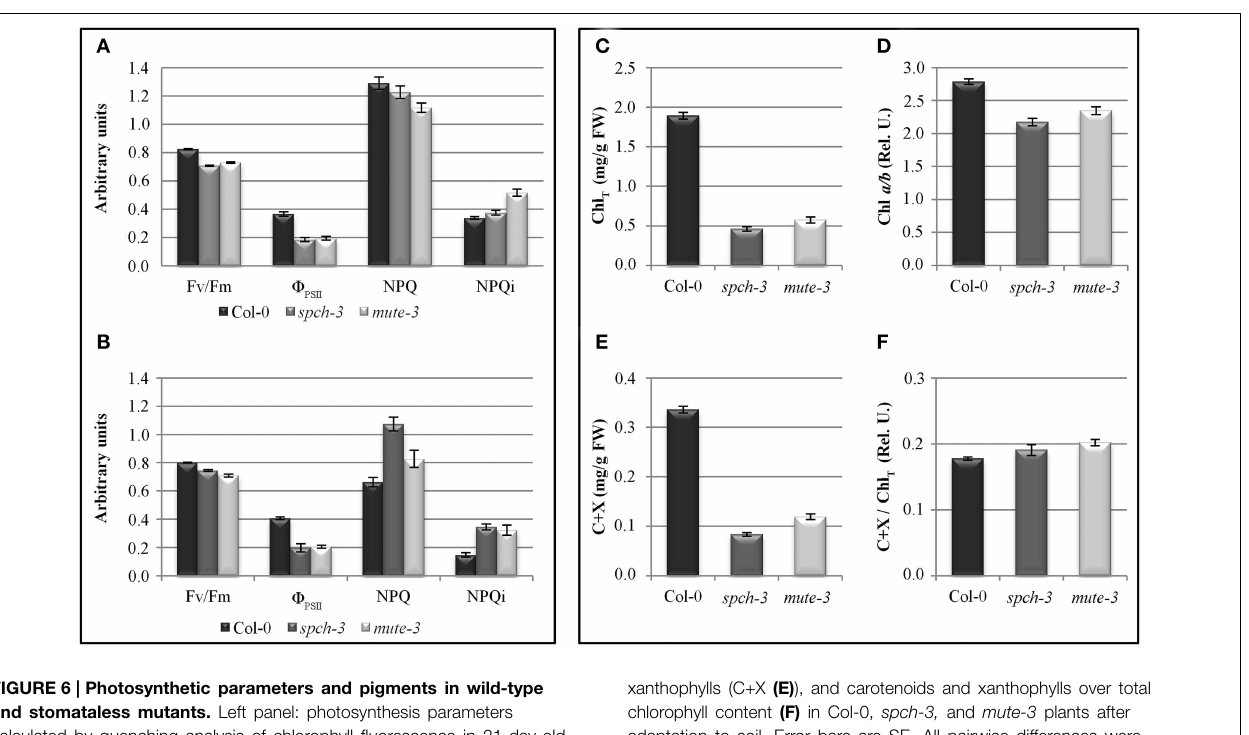
FIGURE 6 | Photosynthetic parameters and pigments in wild-type and stomataless mutants. Left panel: photosynthesis parameters calculated by quenching analysis of chlorophyll fluorescence in 21-day-old plants (A) and after 4 days acclimation to soil (B) . Right panel: total chlorophyll content (Chl T (C) ), Chl a/b ratio (D) , carotenoids and